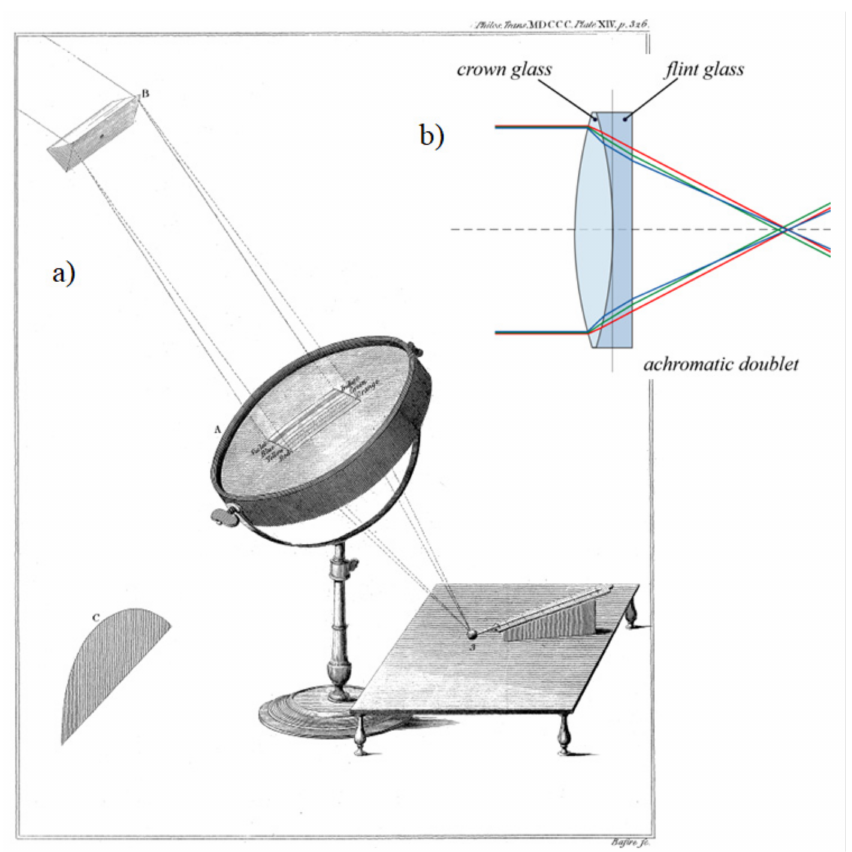
Figure 7. ( a ) Measurement stand for infrared radiation refraction test—original drawing of the measurement stand [10], ( b ) achromat [11]. A—the burning lens, covered; with the prismatic spectrum thrown upon an opening, left for it, in the pasteboard cover (original Herschel’s text), B—prism, C—semicircular cover, 3—the thermometer placed in